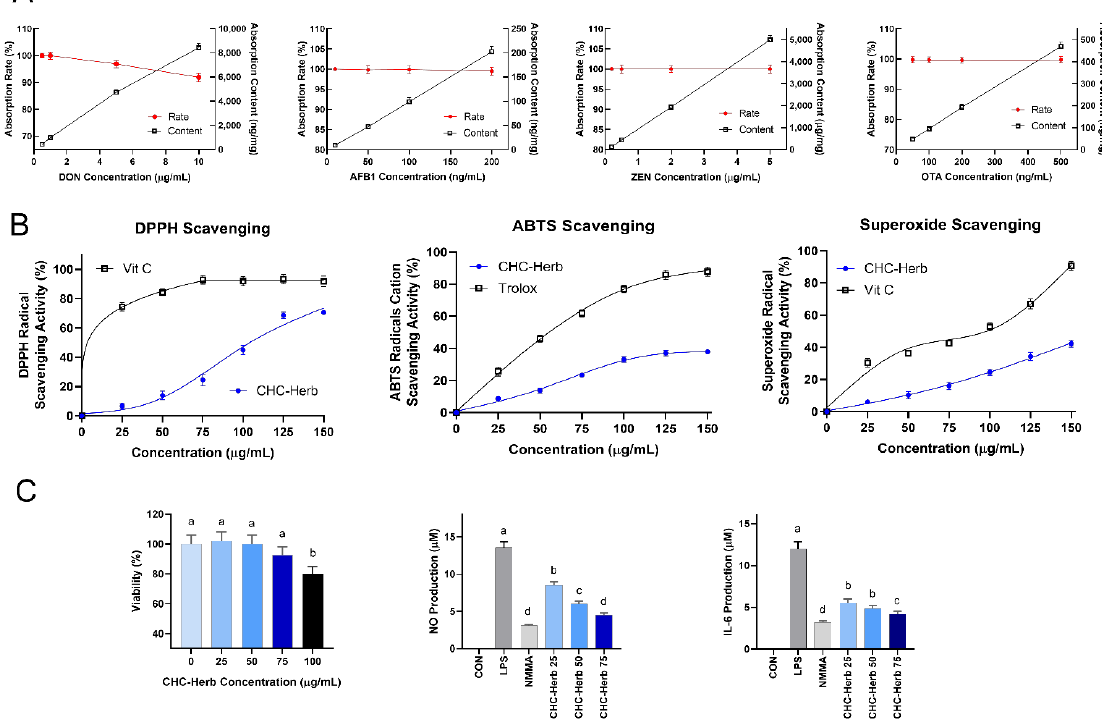
Figure 2. In vitro evaluation of CHC and CHC-Herb activity. CHC absorption rate and absorption of mycotoxin content (DON, AFB1, ZEN, and OTA) ( A ); CHC-Herb scavenging free radicals (DPPH radical, ABTS radical cation, and superoxide radicals) ( B ); and CHC-Herb antioxidative effects in the inhibition of NO production and secretion of anti-inflammatory factor, IL-6, in RAW 264.7 cells ( C ). DON, deoxynivalenol; AFB1, aflatoxin B1; ZEN, zearalenone; OTA, ochratoxin A. Herb, extracts of herbal part of CHC. Vit C, vitamin C. Results are expressed as mean ± standard deviation. Each assay was conducted in triplicate. Cells were pretreated with various concentrations of CHC-Herb for 2 h and then treated with LPS (1 μg/mL) for an additional 24 h. CHC-Herb 25, CHC-Herb 50, CHC-Herb 75, and CHC-Herb 100 represent supplemented doses of CHC-Herb at 25, 50, 75, and 100 μg/mL in cultured medium. Control was DMEM medium, without LPS or CHC-Herb. NMMA (100 μm) was a comparison with CHC-Herb. LPS, Lipopolysaccharide. NMMA, L-N-methylarginine. Bars with different letters represent statistical differences ( p < 0.05).